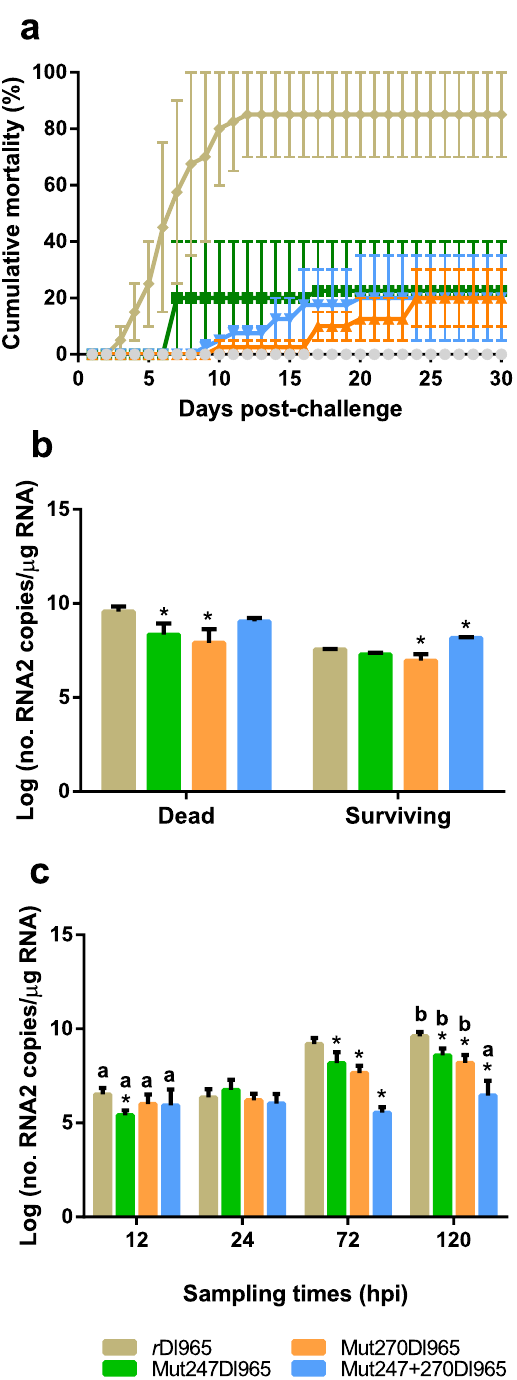
Figure 3. Virulence analysis of r Dl965 and mutated viruses. ( a ) European sea bass mortality inoculated with different recombinant viruses. ( b ) Viral RNA2 quantification in brain from dead and surviving fish. The analysis was performed by RT absolute real-time PCR. The one-way ANOVA was the statistical analysis conducted. Asterisk indicates significant differences, compared to the r Dl965 group, within each group of animals (dead or surviving) (p < 0.05). Results are mean ± s.d. of two pools of three brains. ( c ) RNA2 quantification in brain from sampled sea bass. The one-way ANOVA and t-student tests were the statistical analyses performed. Asterisk indicates significant differences between each mutated virus and r Dl965 within each sampling time (p < 0.05). Different letters indicate significant differences between 12 h and 5 dpi within each experimental group (p < 0.05). Results are mean ± s.d. (n =